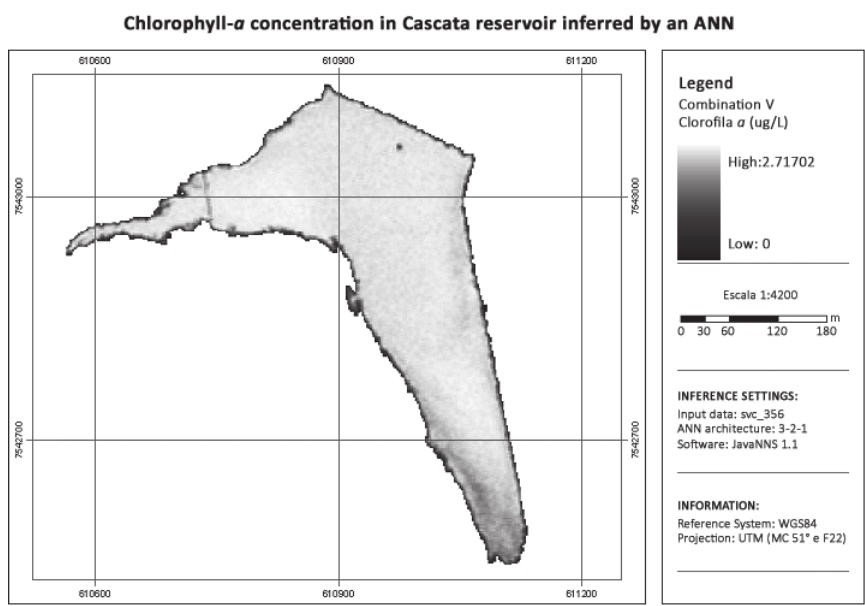
Figure 4 - Chlorophyll concentration inferred from smoothed spectral bands 3, 5 and 6 of Worldview-2